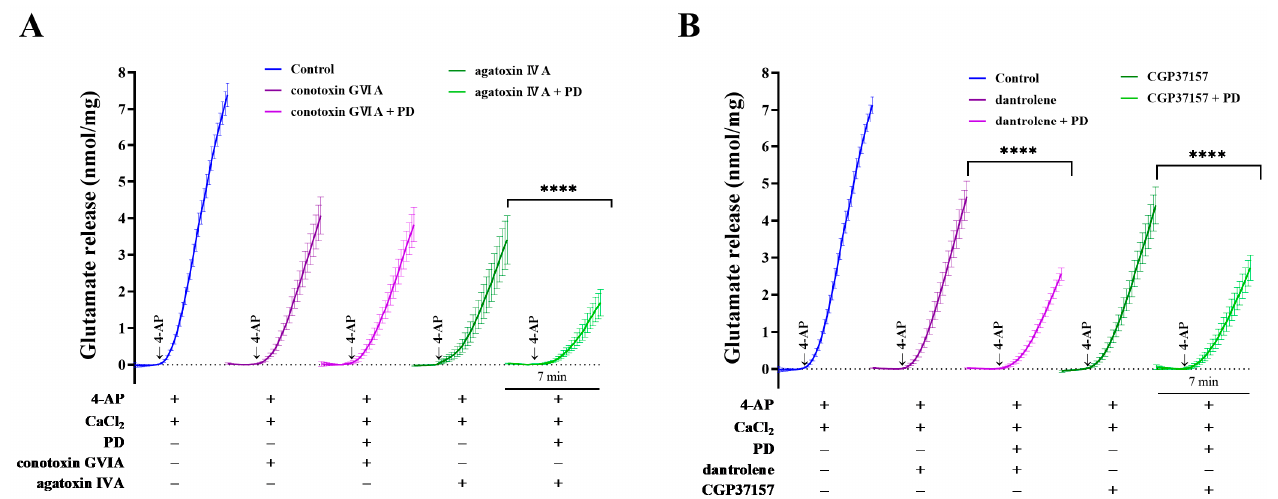
Figure 6. Sensitivity of the PD-mediated inhibition of 4-AP-evoked glutamate release to the N-type VDCC blocker ω -conotoxin GVIA (0.5 µM), P/Q-type VDCC blocker ω -agatoxin IVA (0.1 µM), and inhibitors of the mitochondrial Na + /Ca 2+ exchanger and ryanodine receptor (CGP37157 and dantrolene). ( A ) Isolated synaptosome were divided into 5 experimental groups as follows: (i) control, (ii) ω -conotoxin GVIA, (iii) ω -conotoxin GVIA + PD, (iv) ω -agatoxin IVA and ( ⅴ ) ω -agatoxin IVA + PD. PD inhibits 4AP-induced Ca 2+ entry into nerve terminals through N-type voltage-dependent VDCCs. Each point collected at 2 s intervals represents the data of glutamate release induced by 4- AP in the absence (control) or presence of 30 µM PD. The time points and error bars are shown once for every 10 s for clarity. ( B ) Isolated synaptosome were divided into 5 experimental groups as fol- lows: (i) control, (ii) dantrolene, (iii) dantrolene + PD, (iv) CGP37157 and ( ⅴ ) CGP37157 + PD. PD application maintained the inhibitory effect on glutamate release in the presence of dantrolene (10 µM) or CGP37157 (10 µM). Data are presented as the means ± SEMs of 5 independent experiments from isolated synaptosomes ( n = 5 per group). **** p < 0.0001 compared with ω -agatoxin IVA, dan-